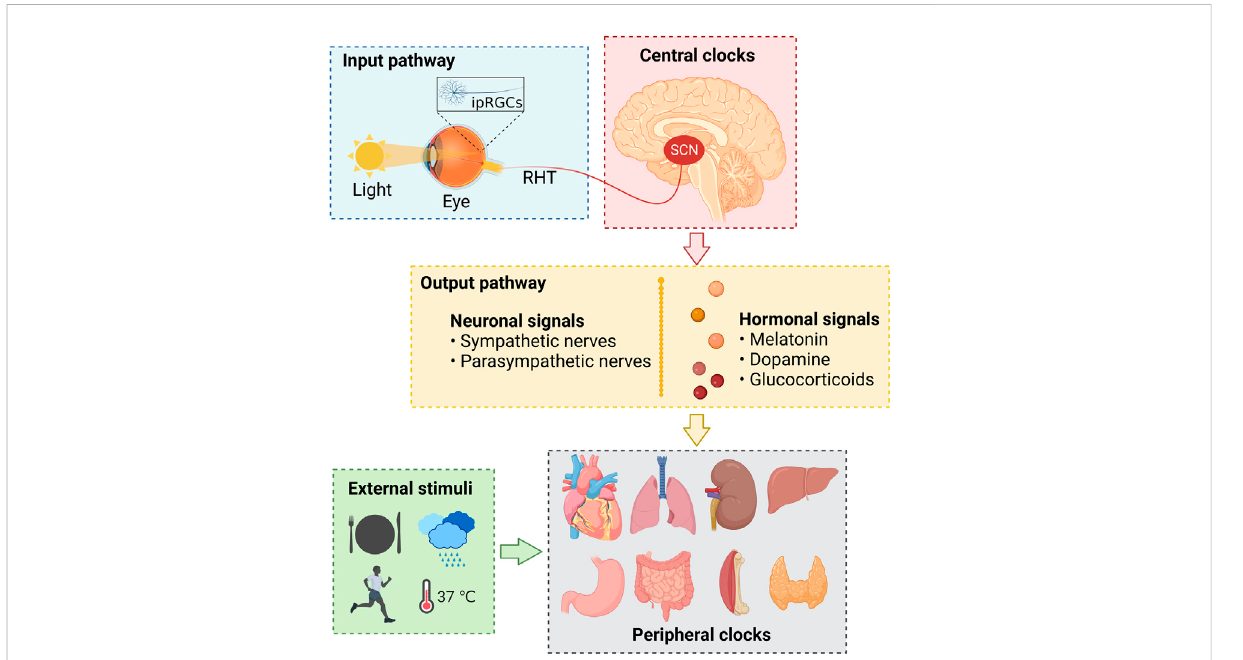
FIGURE 1 The physiological basis of human circadian rhythms. ipRGCs, intrinsically photosensitive retinal ganglion cells; RHT, retinohypothalamic tract; SCN, suprachiasmatic